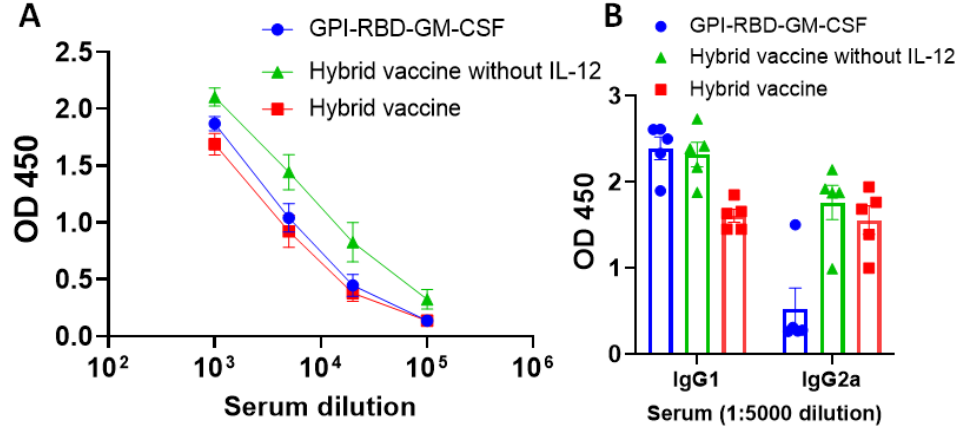
Figure 3. Hybrid vaccine induces antibody response against RBD in mice . ELISA plates were coated with GPI-RBD-GM-CSF, and serum samples from various groups of mice ( n = 5) immunized with GPI-RBD-GM-CSF, VLP vaccine containing the GPI-RBD-GM-CSF or hybrid vaccine (VLP vaccine containing the GPI-RBD-GM-CSF + GPI-IL-12) were diluted and added to the wells after blocking the plates. ( A ) Total IgG levels 6 weeks after booster dose, and ( B ) IgG isotype in the sera 10 weeks after the booster dose. Anti-mouse IgG ( A ) or isotype-specific anti-mouse IgG-HRP conjugate ( B ) was used to detect the bound antibody.